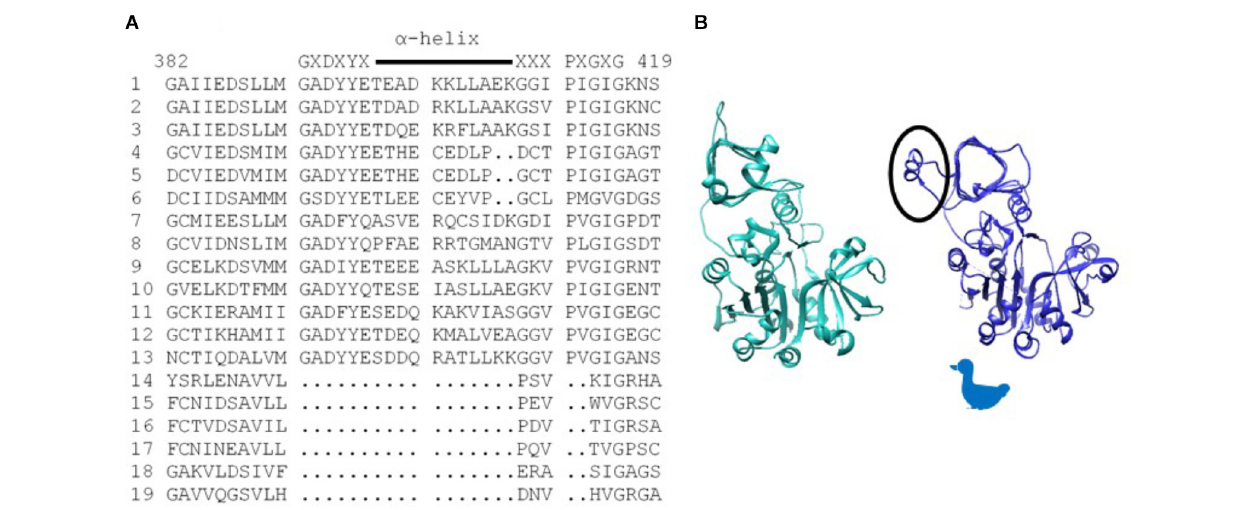
FIGURE 1 | (A) Alignment of various AGPase sequences showing the sequence of the structure unique to chloroplast containing organisms. Consensus sequence is written above, and the α -helix is indicated with a line. Numbering is from the BT2 sequence. (1) Maize BT2, (2) Potato small subunit, (3) M. sagu agpll, (4) M. pusilla ADG1, (5) M. commode ADG1, (6) C. reinhardtii STA6, (7) Anabaena, (8). N. sphagnicola, (9) Maize SH2, (10) Potato large subunit, (11) M. pusilla ADG2A, (12) M. commode ADG2A, (13) C. reinhardtii STA1, (14) A. tumefaciens, (15) E. coli, (16) A. ursilacus, (17) C. grimmiae, (18) Curtobacterium sp., (19) Streptomyces sp. (B) Agrobacterium subunit (sea green) and potato small subunit (blue) highlighting (circled) the potato structure (GaG) protruding from the fourth loop of the p-helix. Because the subunit structure approximates the profile of a duck, the duck is used in subsequent figures to aid in understanding dimer and tetramer structures.